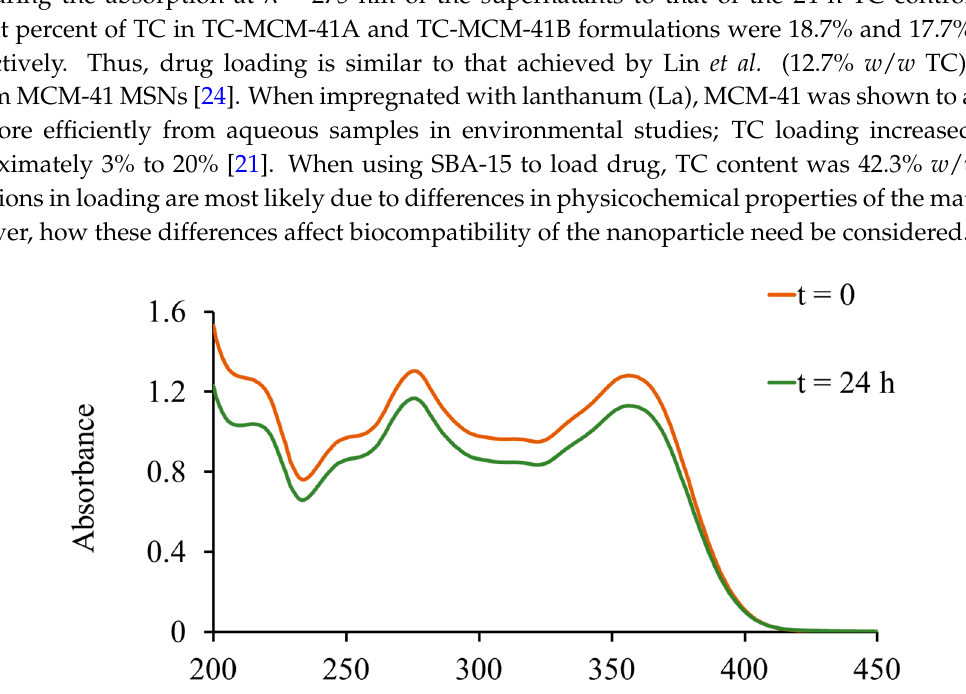
Figure 3. Adsorption of tetracycline (TC) by MCM-41A and MCM-41B. UV-Vis spectra of TC control at 24 h and TC not adsorbed by MCM-41A (green) and MCM-41B (light green). Percent drug adsorption was measured by comparing absorbance at 275 nm. 2.2. In Vitro Drug Release The in vitro release of TC in phosphate buffered saline (PBS; pH 7–7.2) at 37 °C was measured using UV-vis spectroscopy. Release was determined at 0, 0.5, 1, 3 and 5 h for both TC-MCM-41A and TC-MCM-41B (Figure 4). A burst release was observed in both formulations at t = 0 and most drug was released by the end of the 5 h observation period (86% and 94% for TC-MCM-41A and TC-MCM-41B, respectively), although most TC was released over the first hour. The drug release from our formulations in PBS is faster, compared to the formulation by Lin et al. [24] in simulated biological fluid (SBF; pH 7.4)